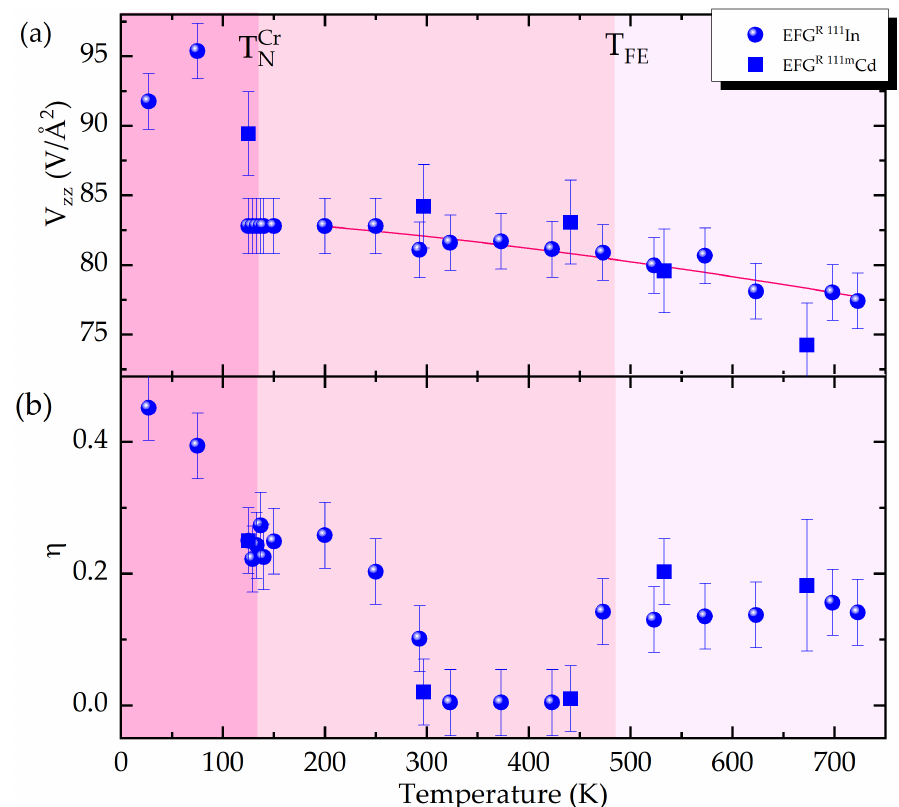
Figure 3. ( a ) Experimental electric field gradient principal component with 111 In and 111m Cd probes for the ErCrO 3 sample. The continuous line represents a least-squares fit of the function V zz ( T ) = V zz ( 0 )( 1 + α T 3 / 2 ) to the data points. ( b ) Asymmetry